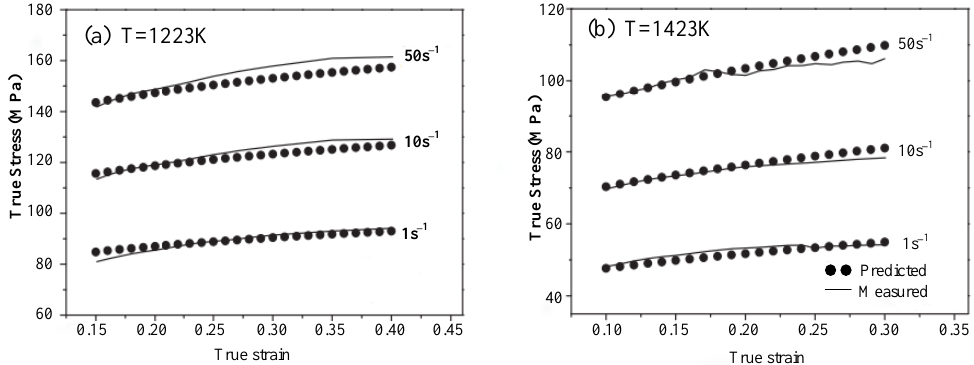
Figure 2. Flow stress comparison curves of 42CrMo, ( a ) 1223 K; ( b ) 1423 K [14].